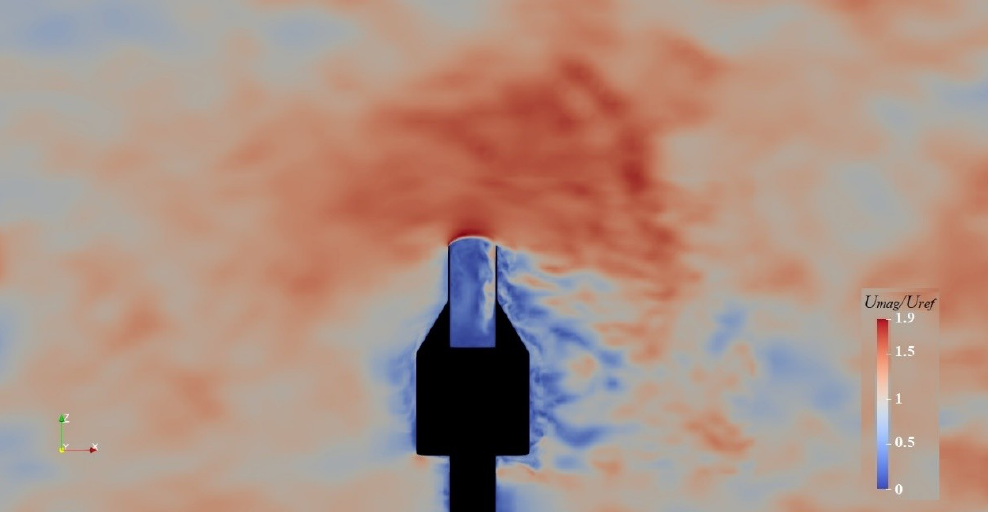
Figure 7. Normalized magnitude ( U mag /U ref ) of the instantaneous flow velocity in the vertical plane ( x , z ) at y / D = 0 for the turbulent free-stream conditions.